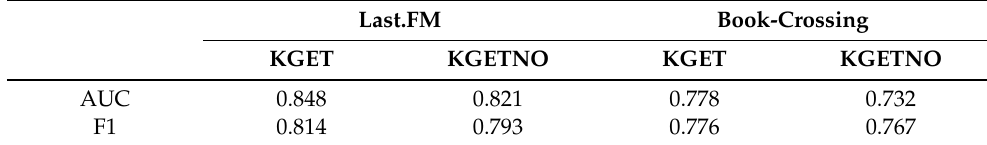
Table 10. The effect of transductive learning.